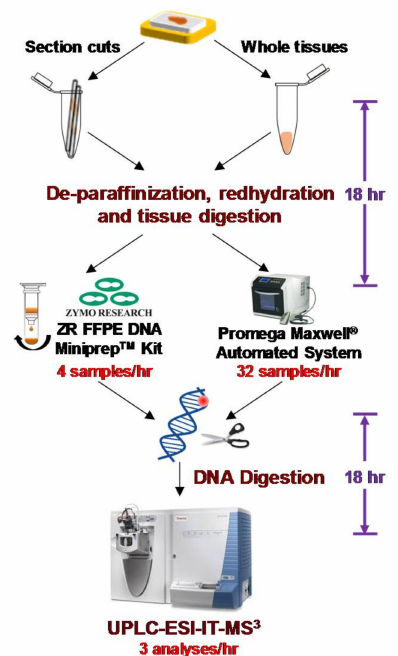
Figure 8. Scheme of FFPE tissue processing for DNA adduct measurements. DNA is extracted from section cuts or excised whole tissues by the FFPE Miniprep kit (Zymo Research) or Promega Maxwell ® automated system. After nuclease digestion, the DNA adducts are measured by UPLC-ESI-IT-MS 3 . The estimated times of the different processes are